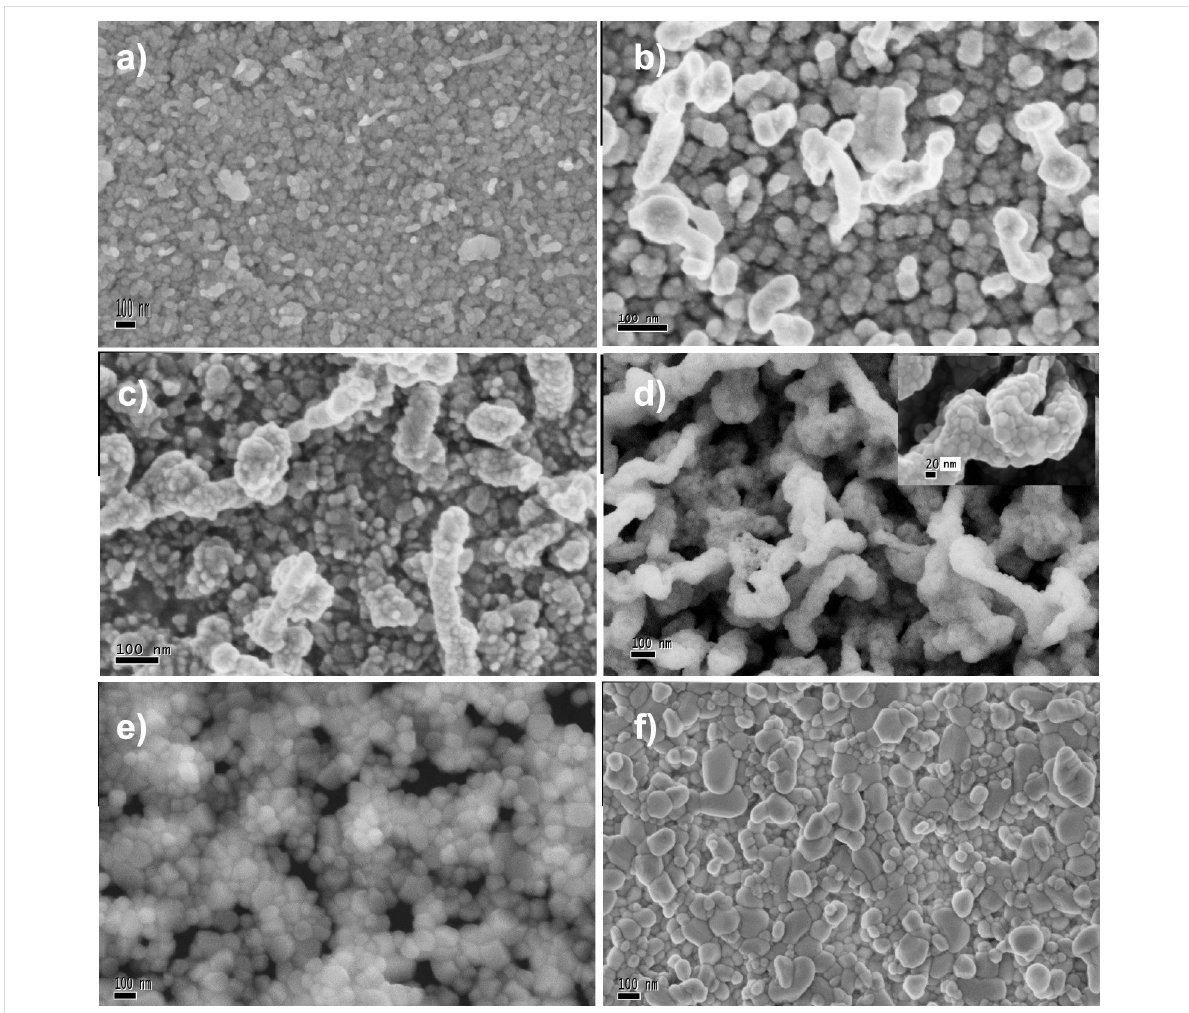
Figure 3: Nanoparticles migrate from source to substrate.